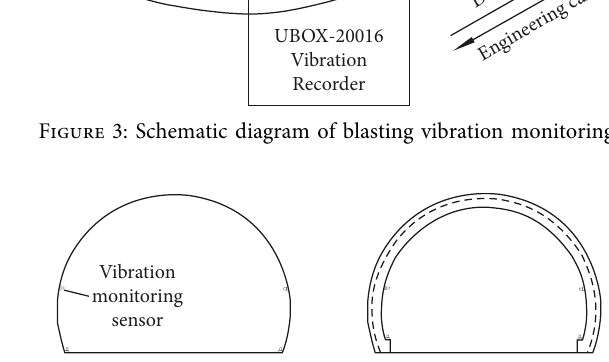
Figure 4: Layout of vibration sensor on tunnel excavation face.